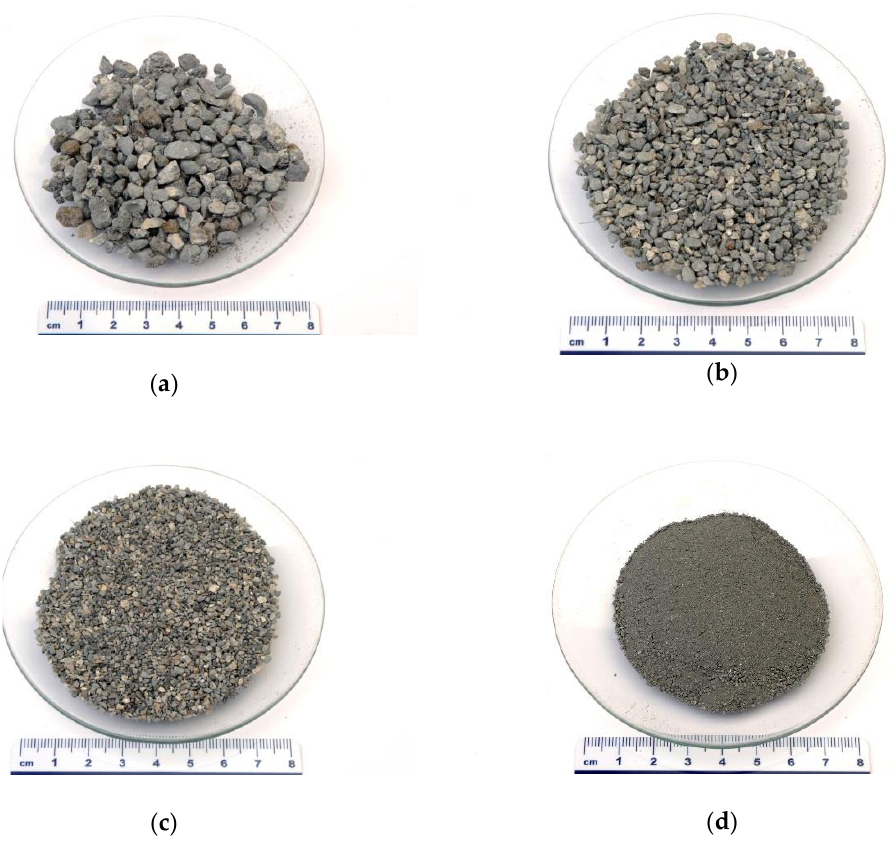
Figure 1. Photographs of refractory material (RM) sieved ( a ) above 4 mm, ( b ) between 2 mm and 4 mm, ( c ) between 1 mm and 2 mm and ( d ) below 1 mm.